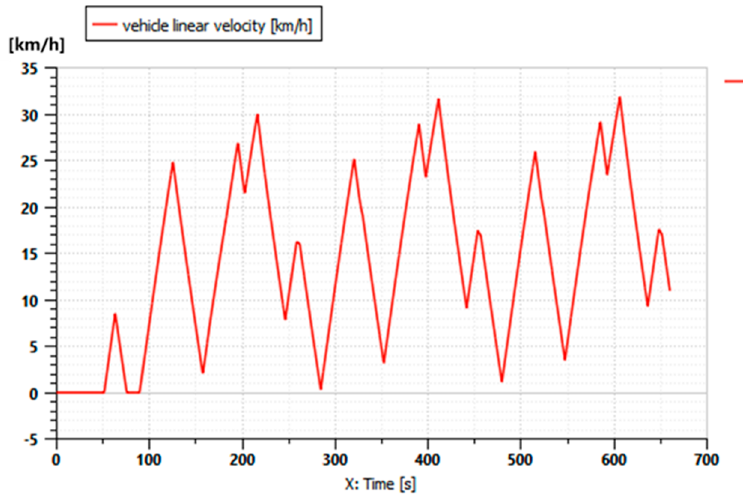
Figure 5. Tractor driving cycle without any attached implements.